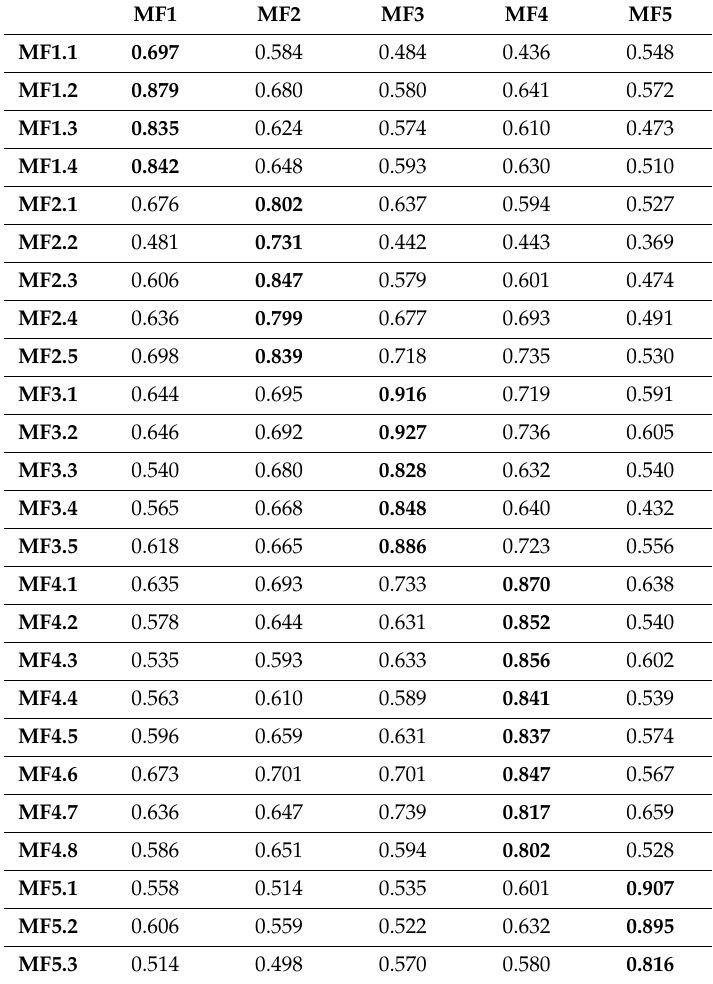
Table 7. Indicator loading and cross loading of motivation factor